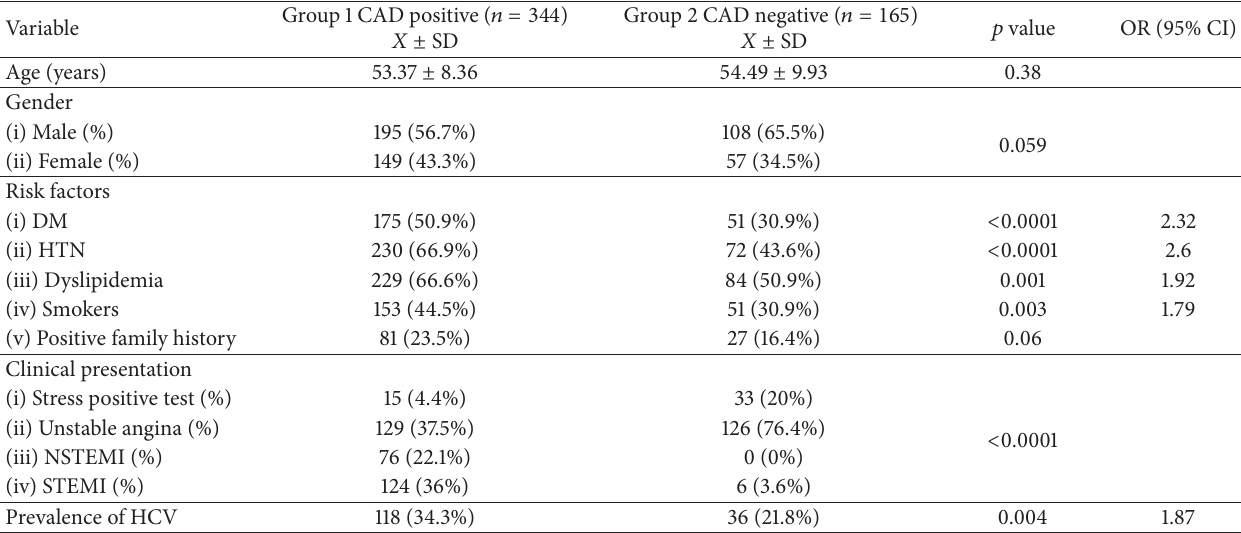
Table 1: Demographic and clinical characteristics of the CAD positive and CAD negative groups.